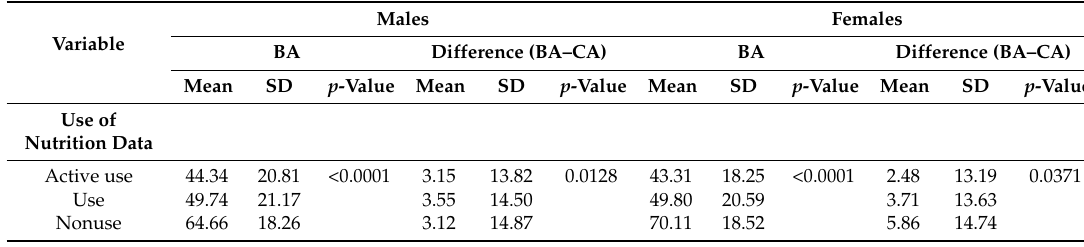
Table 2. Average BA and BA–CA by independent variable.